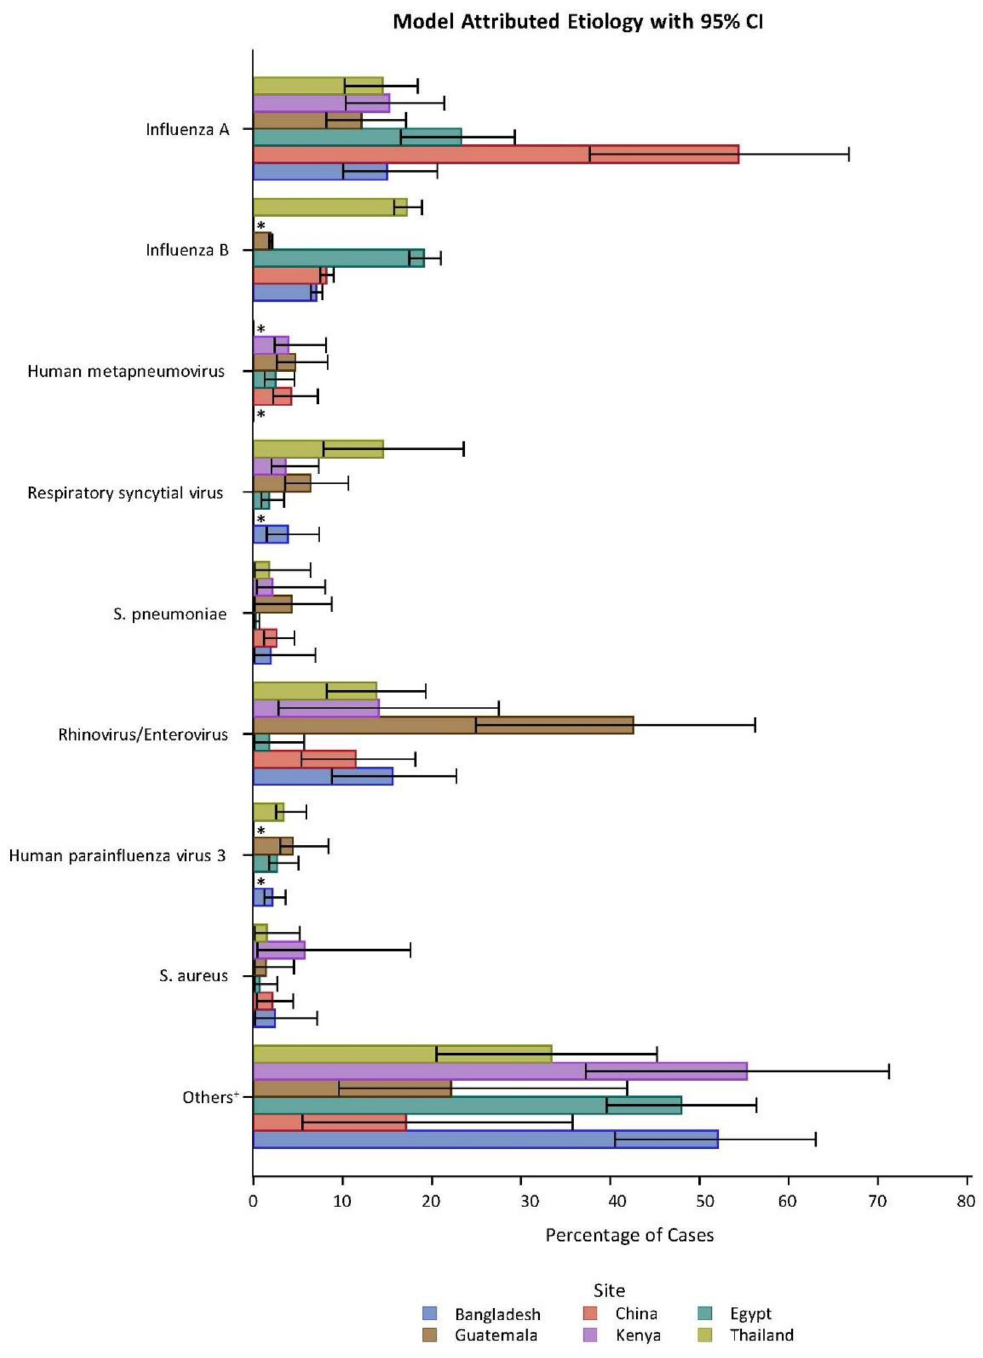
Fig 3. Estimated attributed etiology by pathogen and site � . Bar represents 95% credible interval. � Indicates countries with no etiology attributed to pathogen. +Percentage that could not be attributed to one of these eight pathogens, including pathogens not included on the